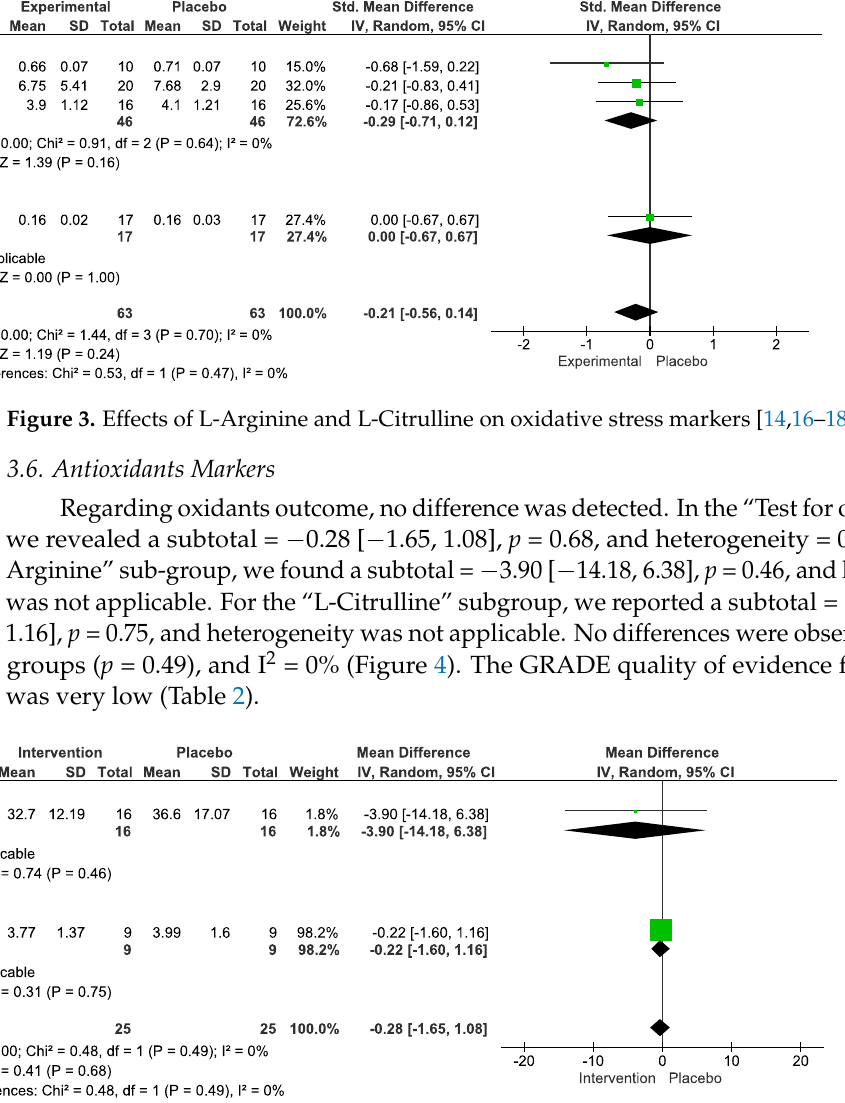
Figure 4. Effects of L-Arginine and L-Citrulline on antioxidant markers.